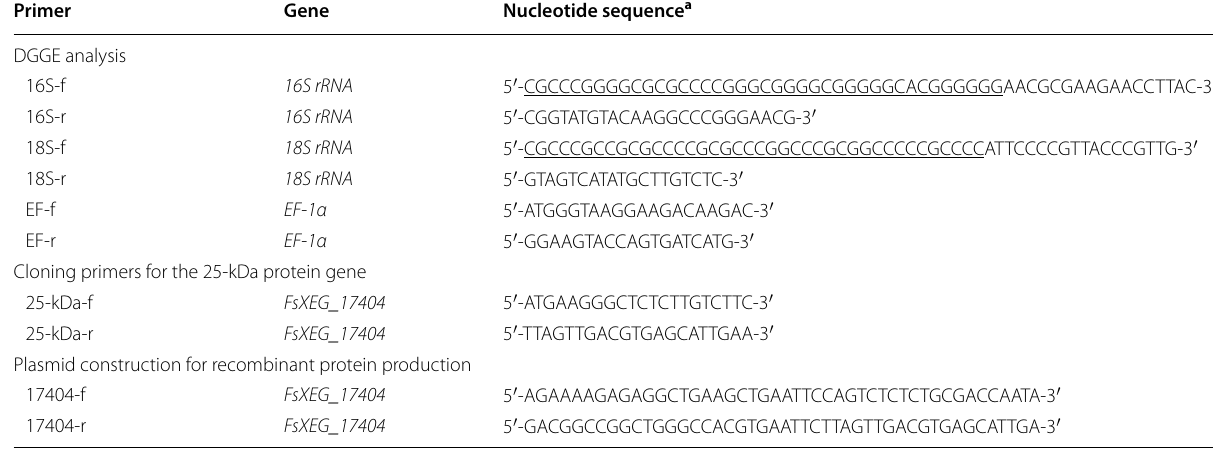
a GC-clamps are underlined. Primers for 16S rRNA and 18S rRNA were designed according to Muyzer et al. (1993) and May et al. (2001), respectively